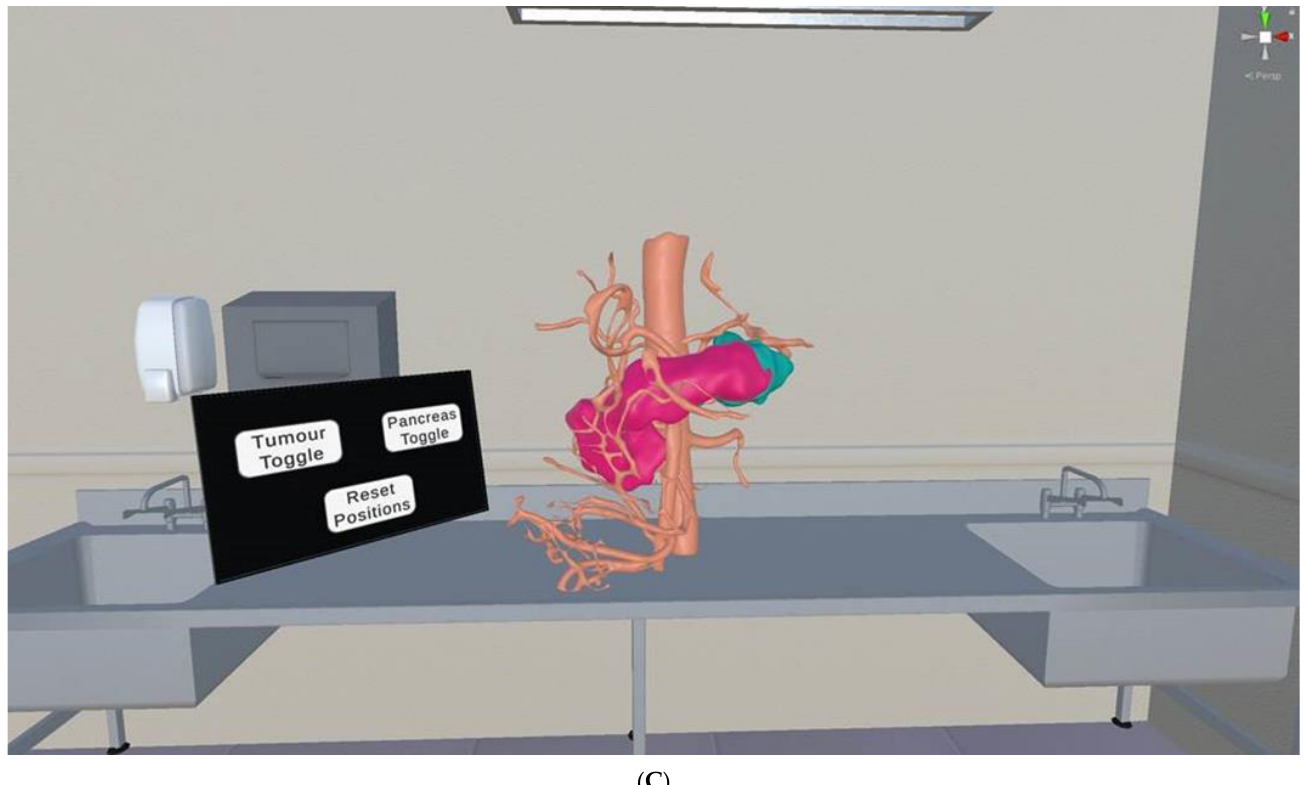
Figure 20. Clinical value of 3D-printed pancreas model in comparison with virtual reality (VR). ( A ): 3D-printed pancreatic model and abdominal aorta and arterial branches were placed together. ( B ): 3D-printed pancreatic model and abdominal aorta model separately. ( C ): VR screenshot of 3D view of pancreatic tumour (green) and pancreatic parenchyma (pink). The blue colour refers to a normal pancreatic parenchyma, and the white colour indicates the pancreatic tumour in images ( A , B ).